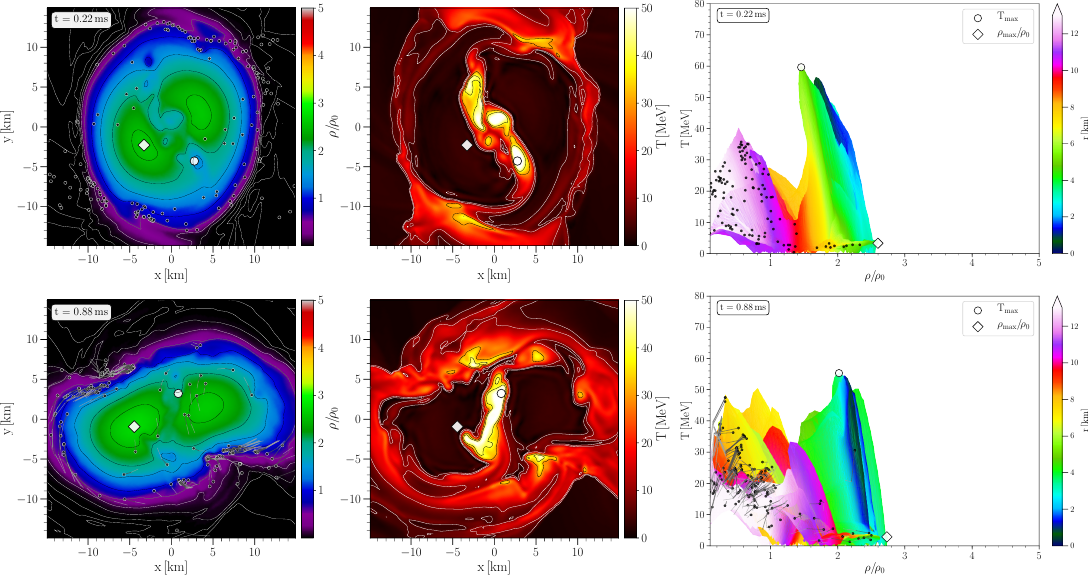
Figure 1. Spatial distribution of the rest-mass density ( left ) and temperature ( middle ) of the LS220-M135 simulation at several time snapshots within the early post-merger phase. ( right ) The pictures on the right side show the density-temperature profiles inside the inner region of the HMNS in the style of a T - ρ QCD phase